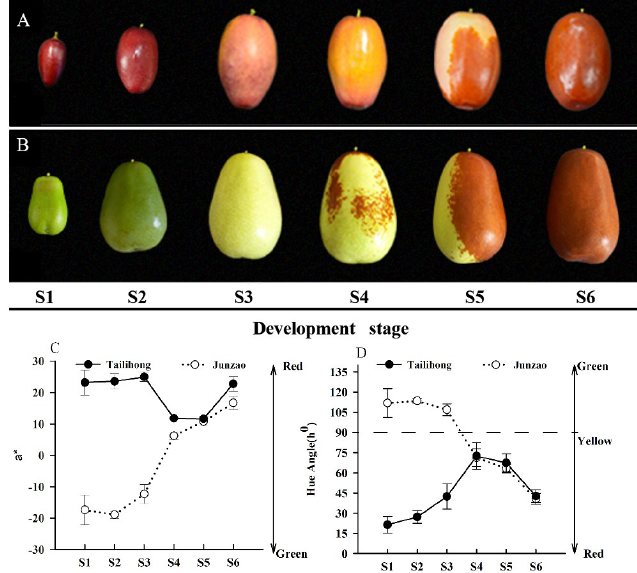
Figure 1. Color changes of jujube fruit development. Photographs of the six development stages S1–S6 of ( A ) ‘Tailihong’; ( B ) ‘Junzao’; ( C ) Fruit development color a*; ( D ) Fruit development color h 0 . Developmental stages S1–S6 correspond to days 30, 50, 80, 90, 100, and 110 after